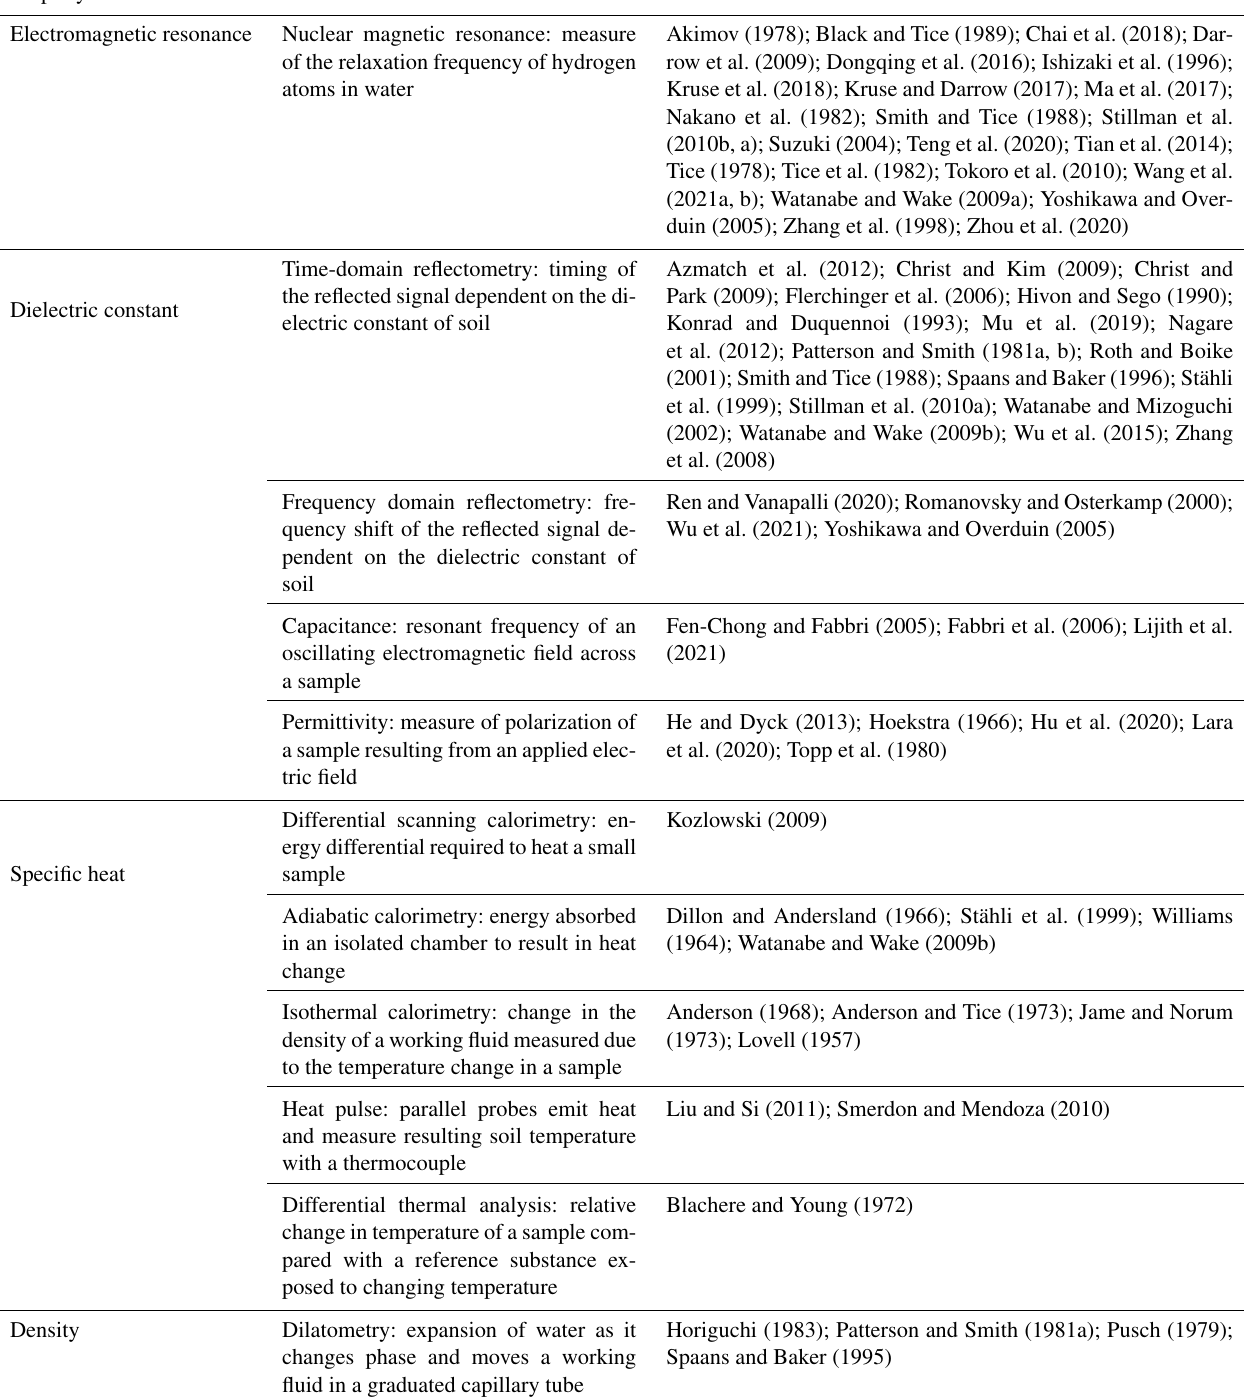
Table A1. Summary of measurements included in the data repository, organized by the property measured and the measurement